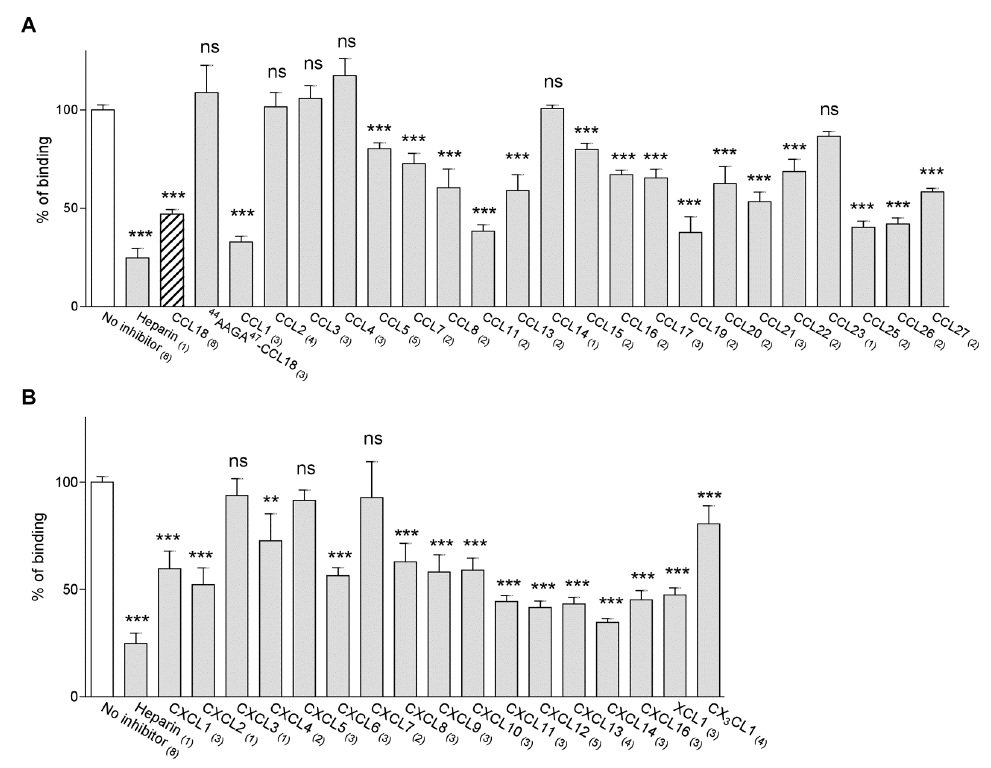
Figure 7. A broad spectrum of chemokines displaces 125 I-CCL18 bound to the cell surface of PBL. Equilibrium competition binding assay on PBL using 125 I-CCL18 and a full spectrum of chemokines. A) CC-chemokines and B) CXC-chemokines, XC and CX C chemokines. Binding of 125 I-CCL18 was competed by a constant concentration of 1 µM competitor. The binding of 125 I-CCL18 3 in the absence of competitor was equalized to 100% of binding (No inhibitor). The data are expressed in % of total binding. Graph represents the mean ± SEM of n independent experiments (in brackets) performed in triplicate.